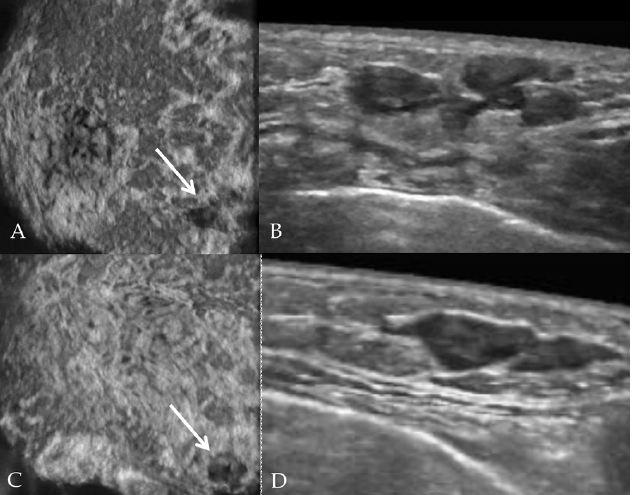
Figure 3. Automated breast ultrasound scan on coronal ( A – C ) and axial planes ( B – D ). The lesion appears as an oval hypoechoic nodule with regular edges, mimicking duct ectasia (arrows).